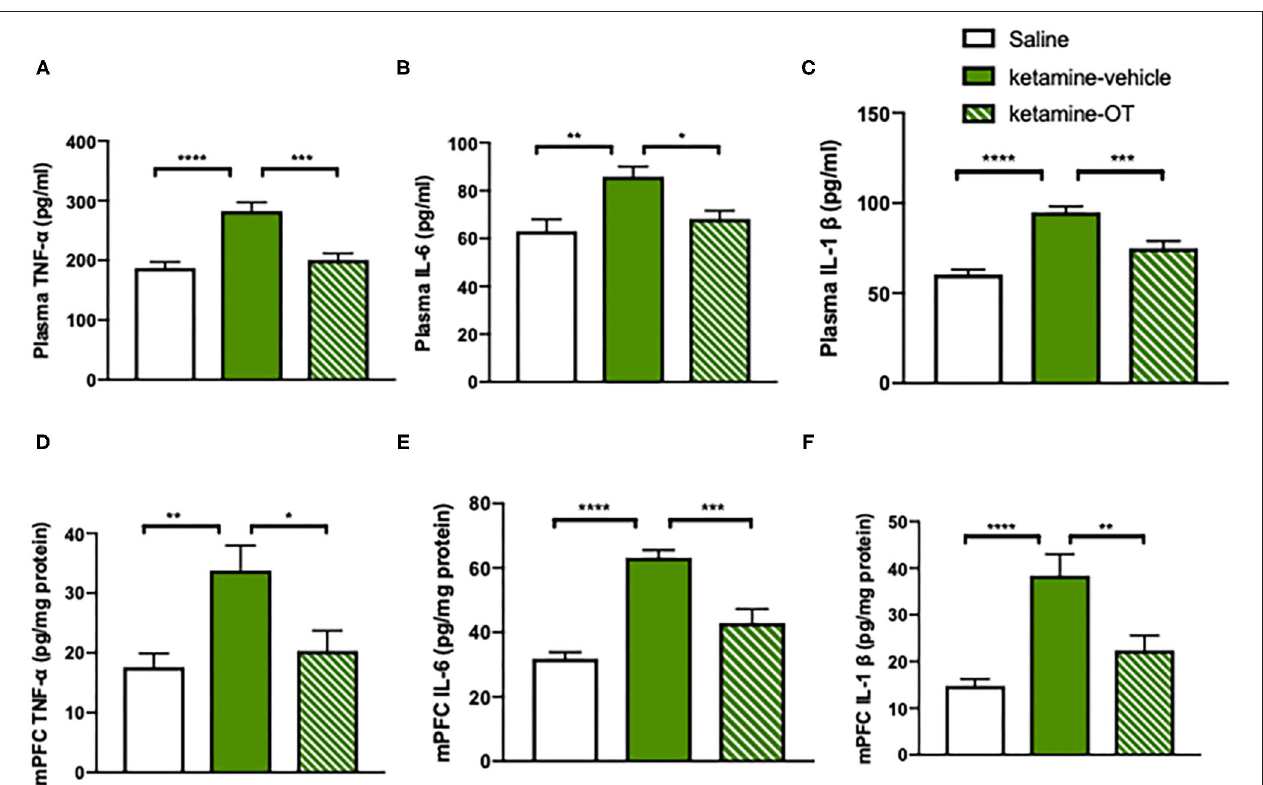
FIGURE 4 | mPFC oxytocin normalizes ketamine-induced cytokines increase in TNF- α , IL-6, and IL-1 β levels. (A) The levels of TNF- α , (B) IL-6, and (C) IL-1 β in the plasma. (D) The levels of TNF- α , (E) IL-6, and (F) IL-1 β in the mPFC measured by ELISA Kit. Data are presented as mean ± SEM. * p < 0.05, ** p < 0.01, *** p < 0.001, **** p < 0.0001, compared with saline or ketamine-vehicle group. n = 9–10 per group. OT,